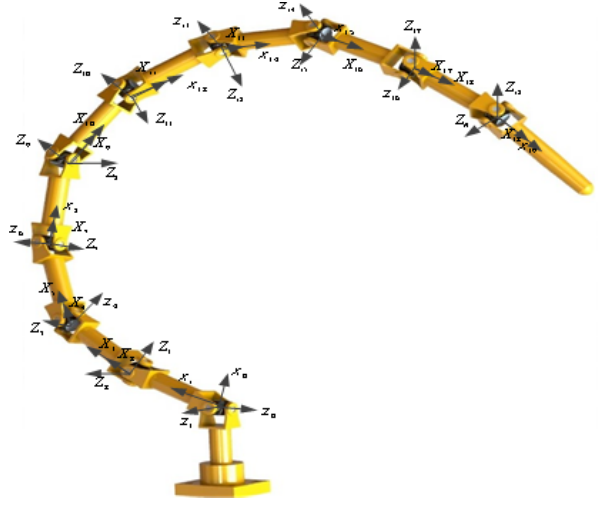
Figure 2. Kinematics model for a hyper-redundant